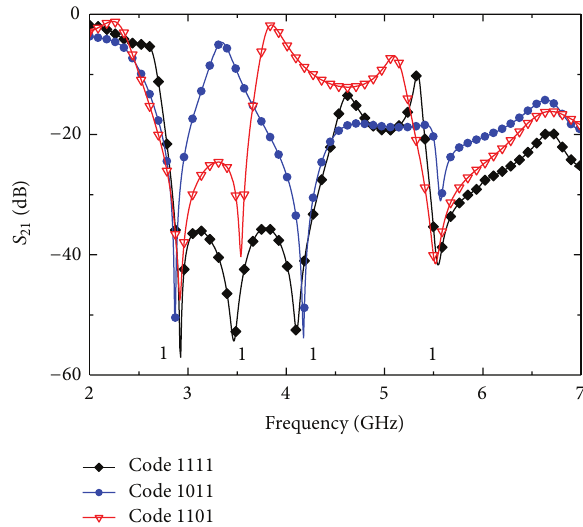
Figure 3: Simulated results for frequency resonant bits on the flexible substrate.